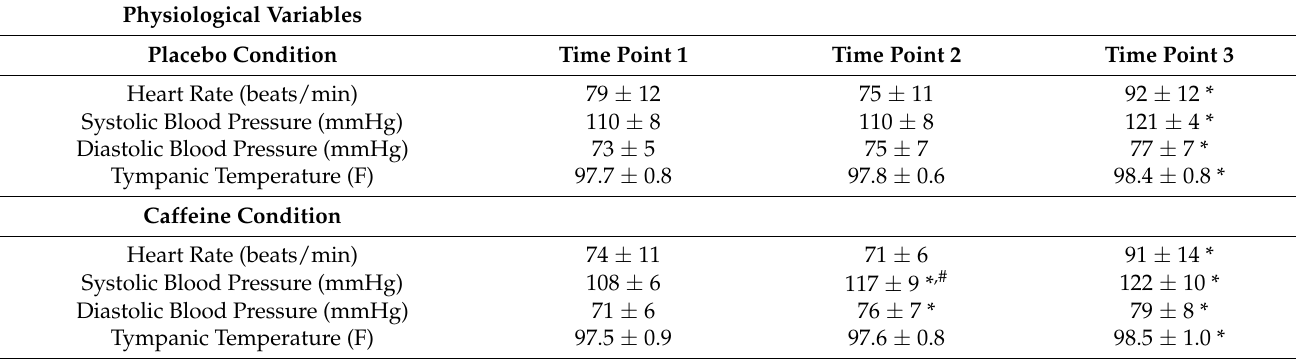
Table 2. The effects of caffeine on physiological measurements.